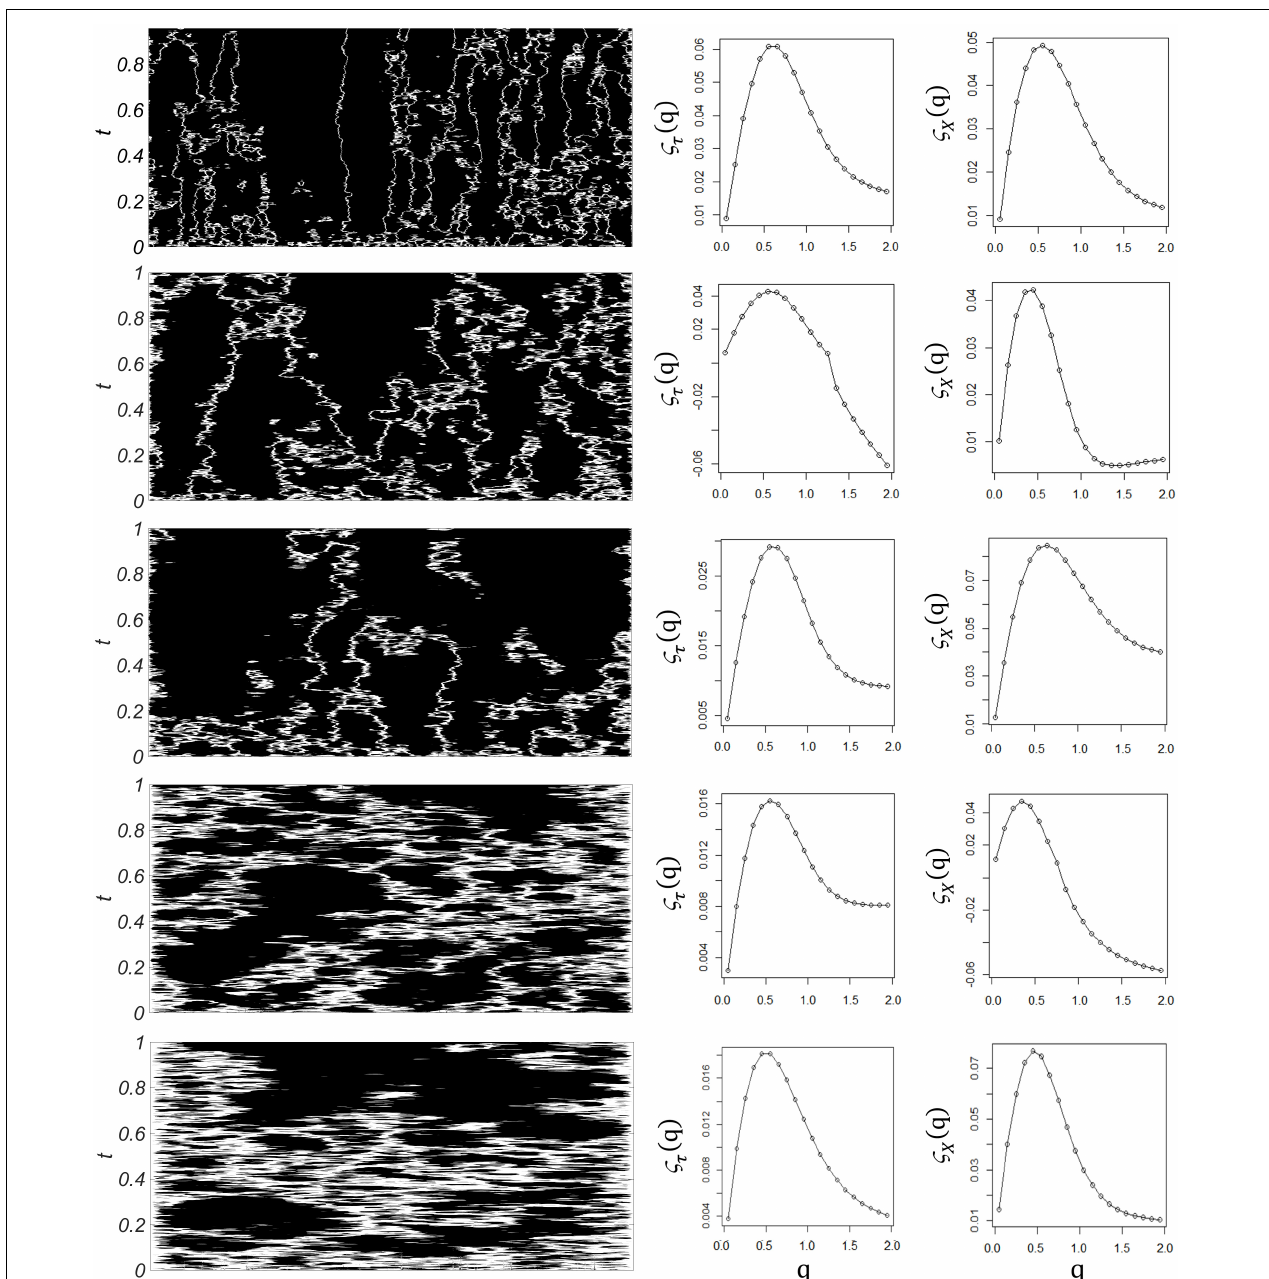
FIGURE 2 | Computer simulations. Left column: Time evolution of the velocity of spikes, u(x,t), as the diffusion coefficient δ increases (from top to bottom), with time on the vertical axis and space on the horizontal axis. White areas represent the parts of the integration domain where the module of the velocity of spikes is below an arbitrary limit (10 8 ), in opposition to black areas, where it is higher than this limit. As the diffusion coefficient increases, white areas are enlarged, as the total velocity diminishes across the integration domain. Middle column: Sample temporal multifractal spectra ζ τ (q) obtained from temporal structure functions of increasing order, at fixed spatial points. Non-linearity indicates temporal multifractality. Right column: Sample spatial multifractal spectra ζ x (q) obtained from spatial structure functions of increasing order, at fixed times. Non-linearity indicates spatial multifractality.